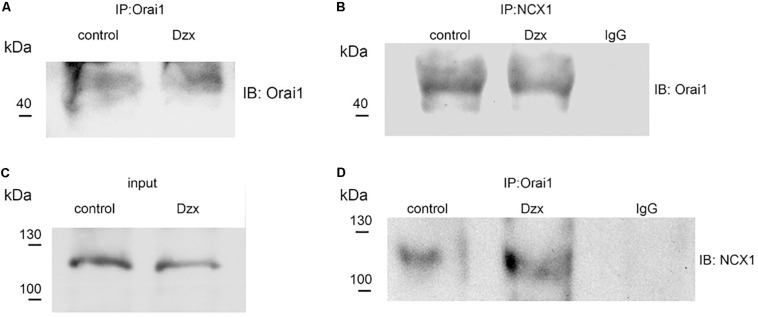
Orai1 associates with NCX1 in the adult rat heart. (A,B) Orai1 and NCX1 were immunoprecipitated from membrane fractions of control and PPC ventricles, respectively, and. immunoblotted with anti-Orai1 antibody. (C) NCX1 from membrane fractions of control and PPC ventricles was immunoblotted with anti-NCX1 antibody (input). (D) Orai1-immunoprecipitated proteins were immunoblotted with anti-NCX1 antibody.